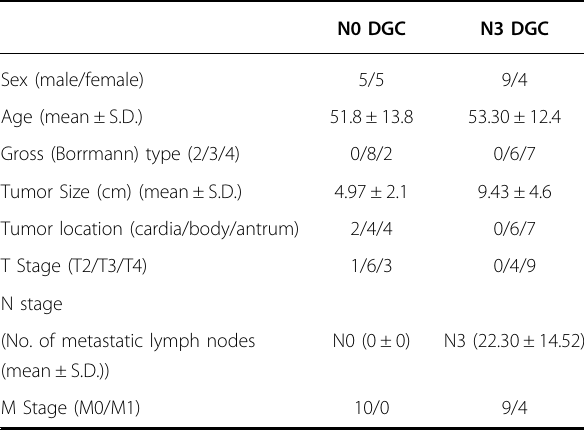
Table 1 Clinical and pathological features of